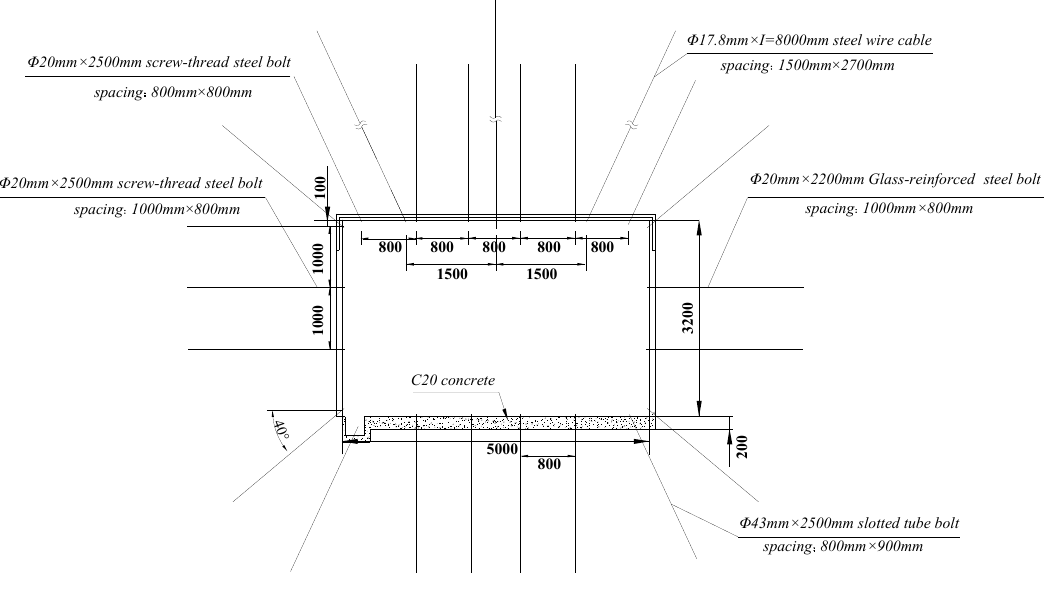
Figure 7. New support section design diagram.